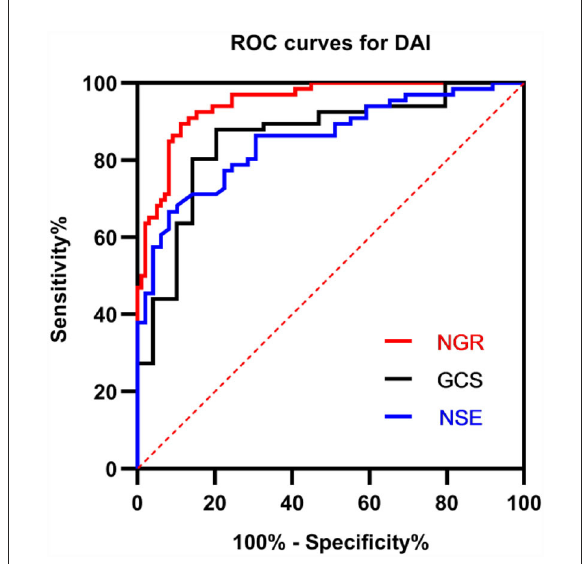
FIGURE3 Receiver operator characteristic (ROC) curves for GCS, NSE, and NGR for early predicting DAI after injury. A larger probability result indicates better predictive power. The area under the curve (AUC) for NGR was 0.9493 (95% CI 0.9125–0.9861, p <